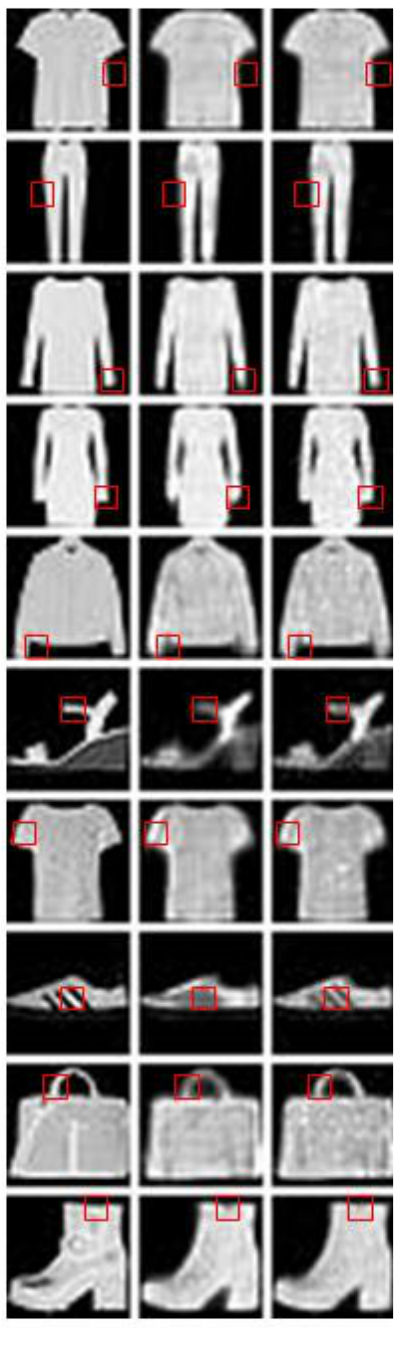
Figure 23. Marked reconstruction images on the FMNIST data set.